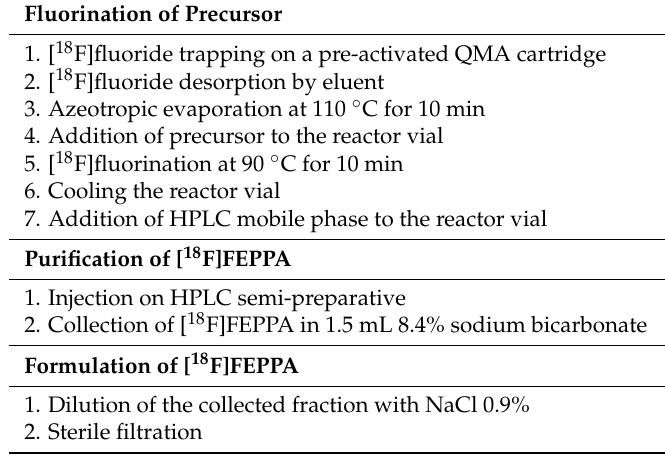
Table 3. Reaction sequence for [ 18 F]FEPPA